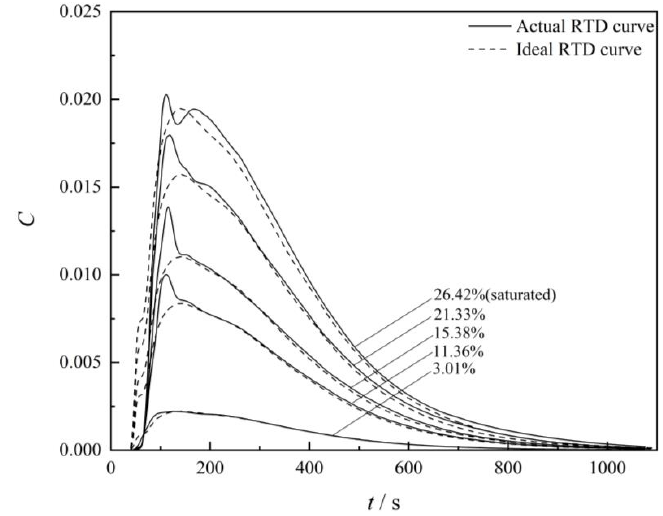
Figure 7. RTD curves for the different tracer mass concentrations.